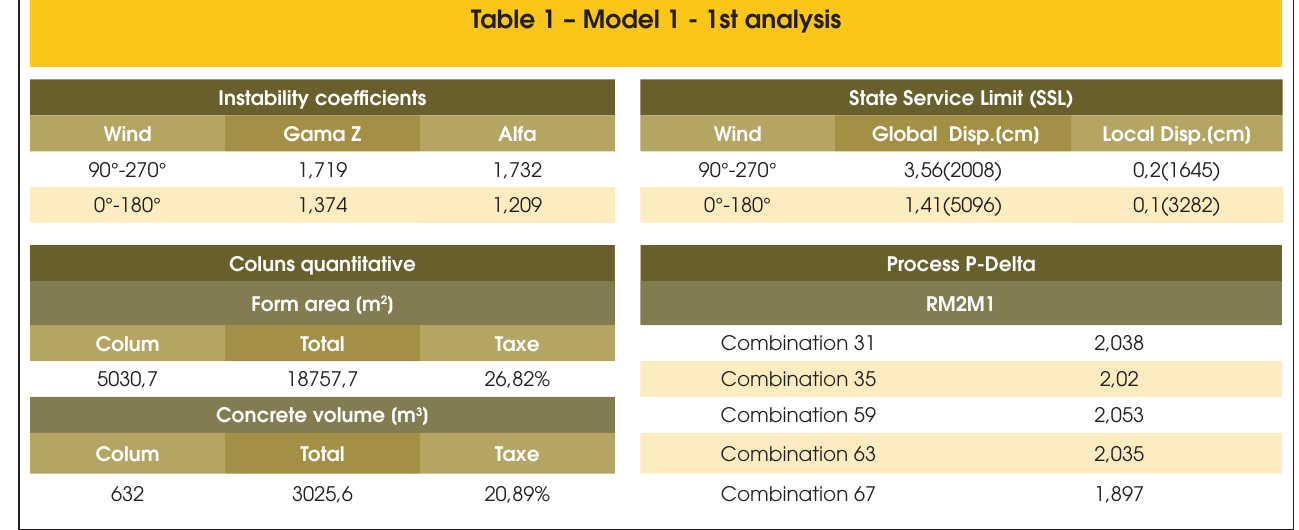
Table 1 – Model 1 - 1st